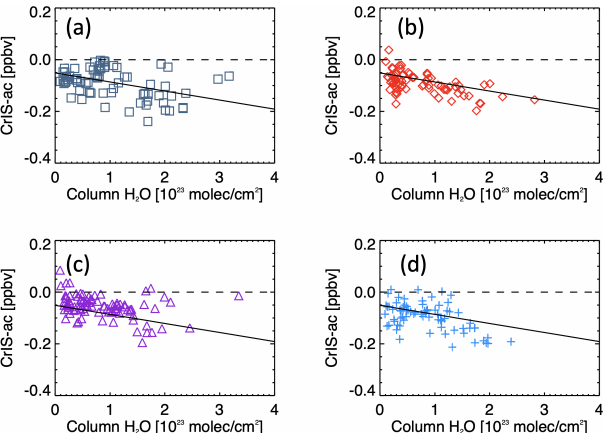
Figure 9. Scatter plots of CrIS–aircraft PAN differences against column water vapor for (a) ATom-1, (b) ATom-2, (c) ATom-3 and (d) ATom-4. The solid black line, which is the same in all panels, shows the result of a linear fit to the data for all four campaign time